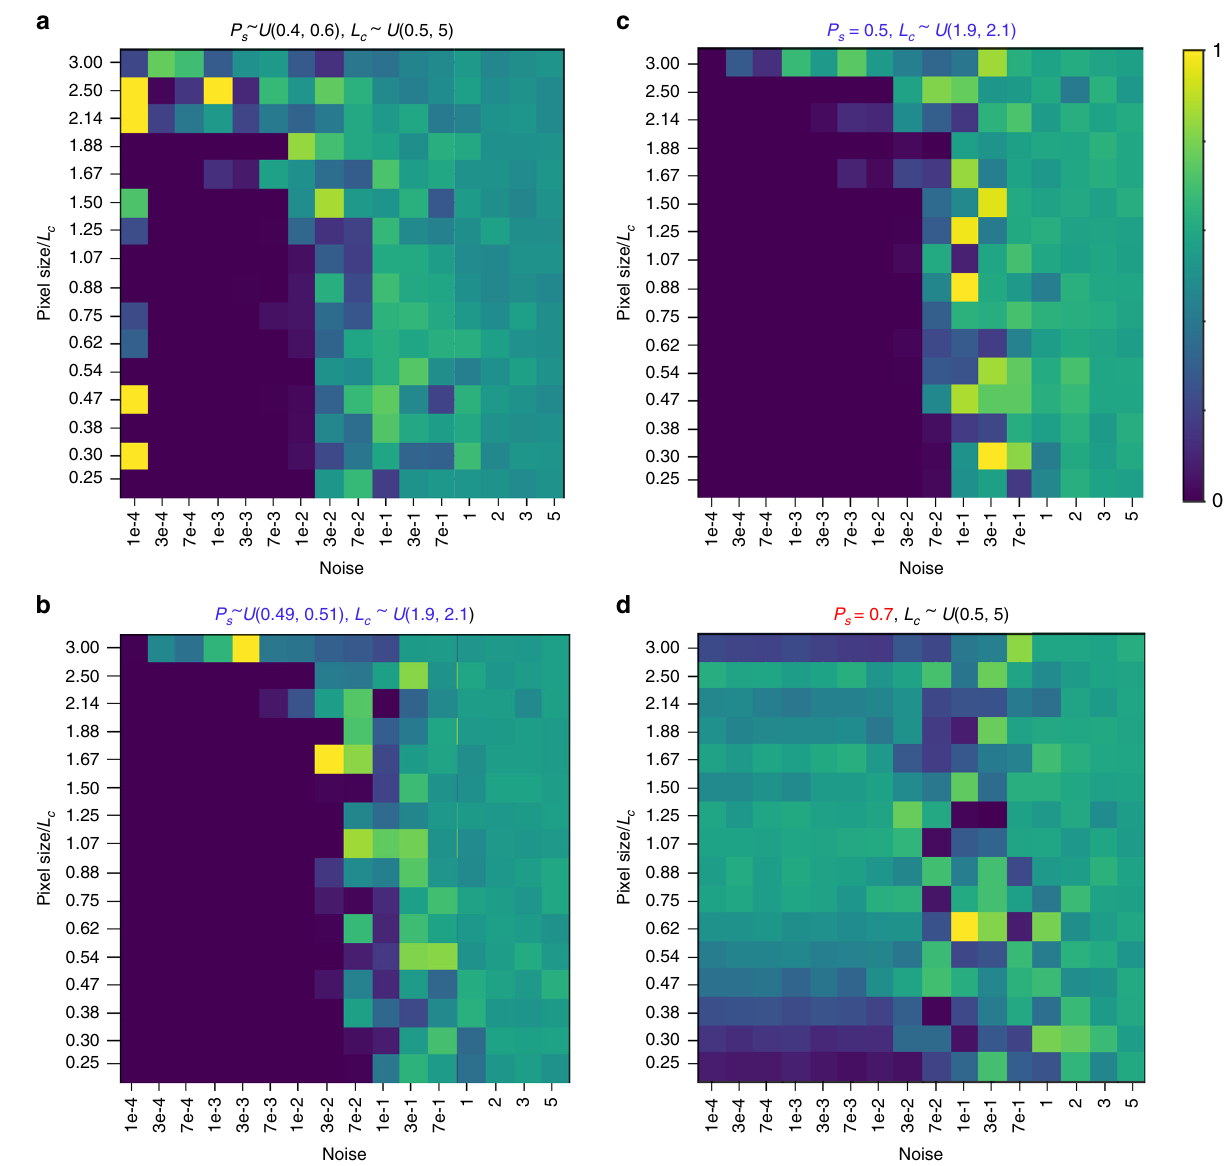
Fig. 7 Effect of prior knowledge on imaging required for model separation. Matrices show the weight for WAIC score comparisons of Models 1 and 2 against synthetic domain wall data as a function of the effective pixel size and noise level. Universal color scalebar is at right of the image, 0 corresponds to models being reliably separated, 0.5 is indistinguishable, and 1 is incorrect inference. The true value of parameters are x 0 = 0, P s = 0.5, L c = 2, and η = 2. The prior distribution of parameters are labeled, black text indicates comparison values, blue represents additional knowledge that allows more informed prior, and red represents incorrect knowledge. a Weakly informed priors on polarization and correlation length. b Strongly informed priors. c Exact polarization and weakly informed correlation length priors. d Incorrect polarization and weakly informed correlation length